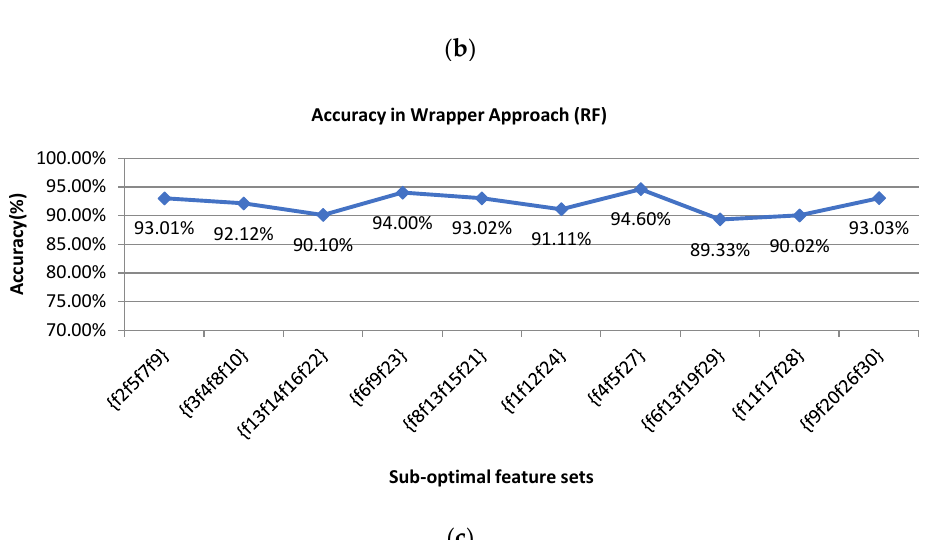
Figure 10. Classification accuracy of different sub-optimal feature sets in wrapper approach: ( a ) estimated by support vector machine (SVM) ( b ) estimated by logistic regression (LR) ( c ) estimated by random forest (RF).